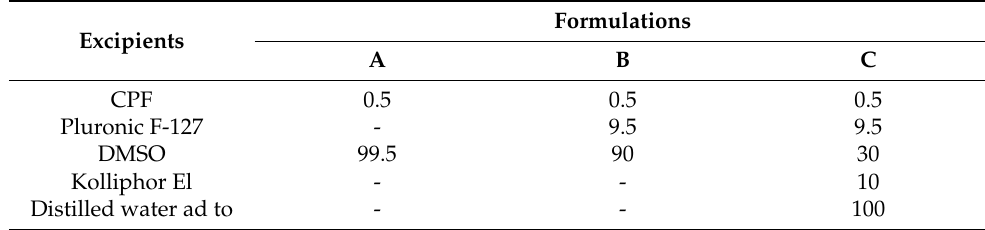
Table 2. The composition (% w / w ) of